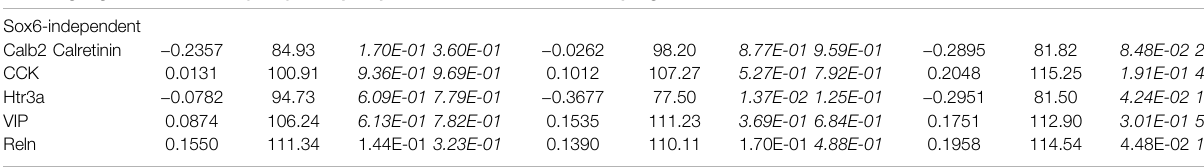
Caudal ganglionic eminence (CGE)- and preoptic area-derived interneuon progenitors c,d